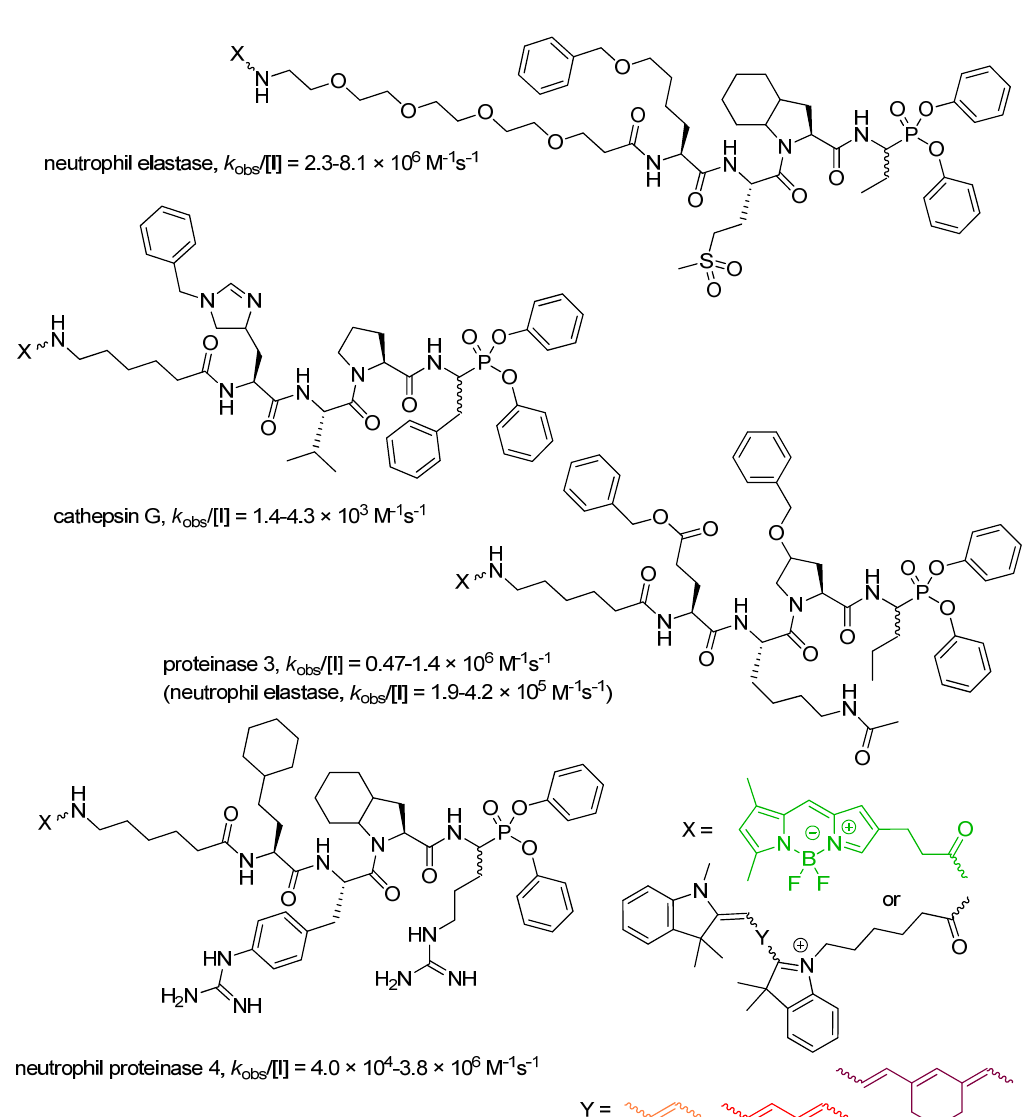
Figure 3. A unique toolbox of fluorescent diaryl phosphonate probes for parallel imaging of human neutrophil serine proteases. Specific sequences and their activities, together with the structures of the reporter fluorophores, are presented.